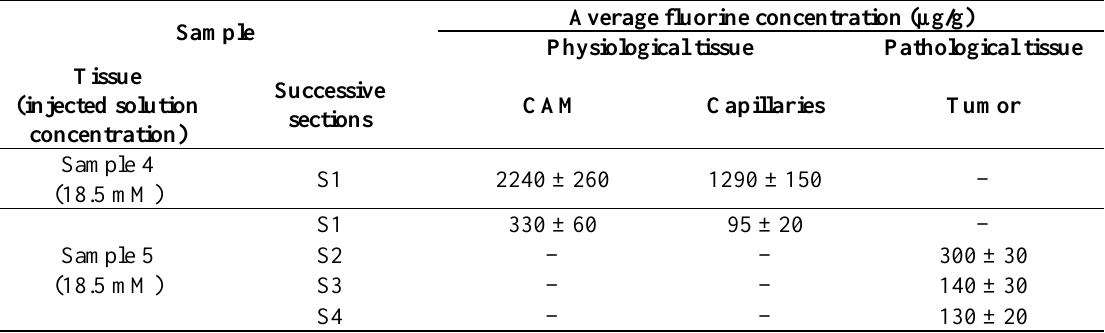
Table 2. Fluorine concentrations in normal or tumor tissues exposed to polyfluorinated glucose (18.5 mM).